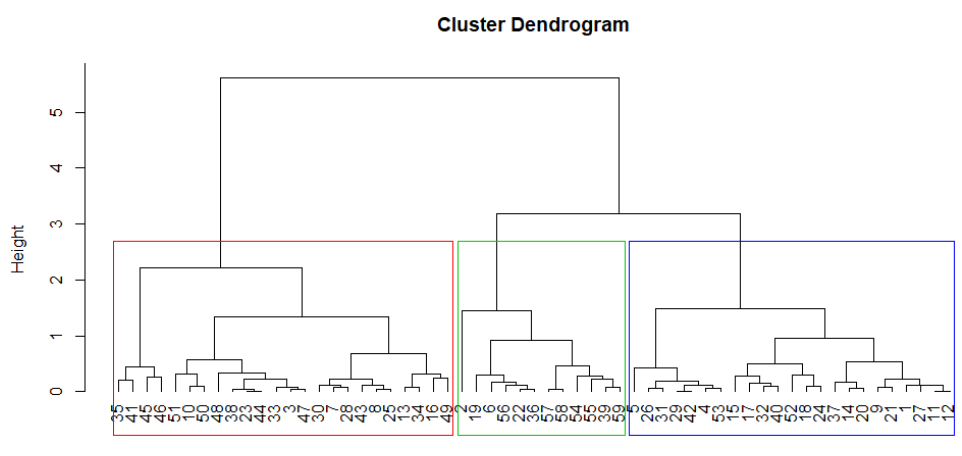
Figure 1: Dendrogram for Ward’s hierarchical clustering method based on the 2006 MPI values for municipalities in Athens